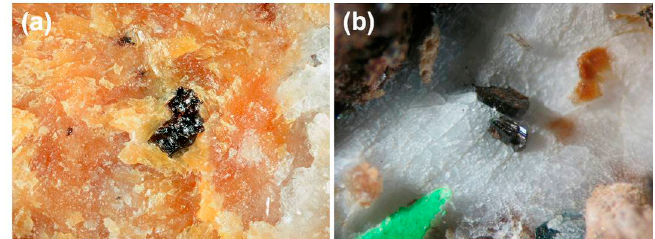
Figure 1. Holotype material of manganiakasakaite-(La) ( a ) and ferriakasakaite-(Ce). In ( a ),